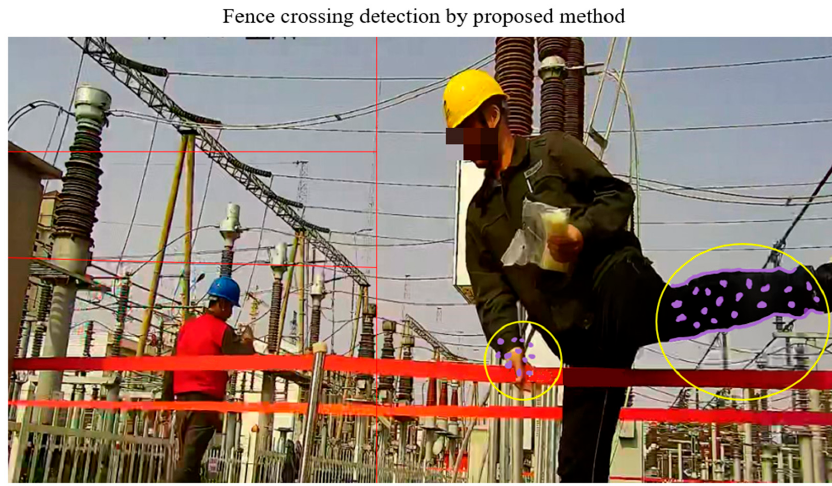
Figure 12. Fence crossing detection.